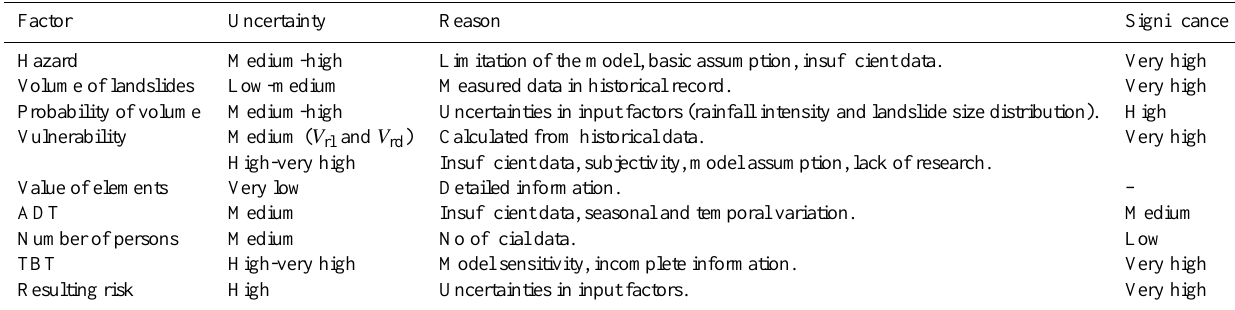
Table 13. Qualitative estimation of uncertainties inherent in input data and results of risk analysis.